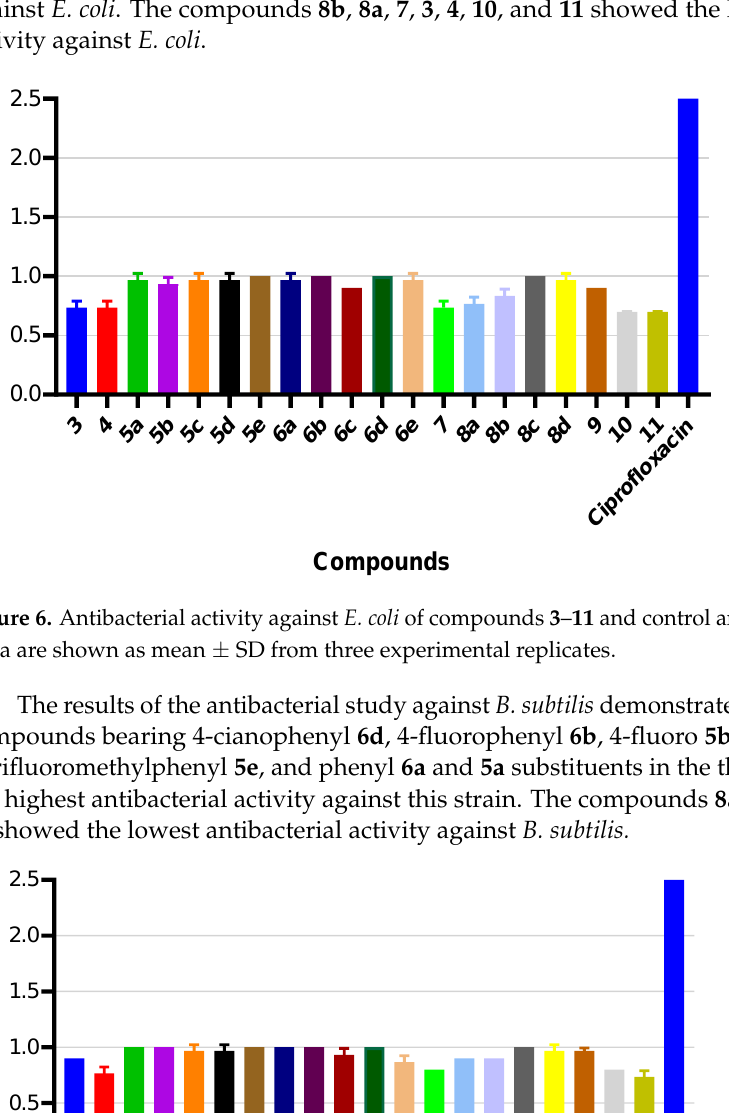
Figure 5. Antioxidant activity by DPPH assay of 3 – 11 compounds and synthetic antioxidant BHT. Data are shown as mean ± SD from three experimental replicates.